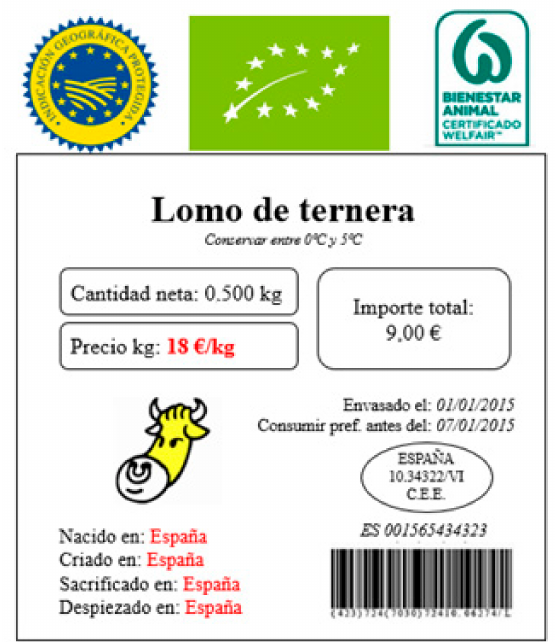
Figure 1. An example of a beef label presented in the conjoint